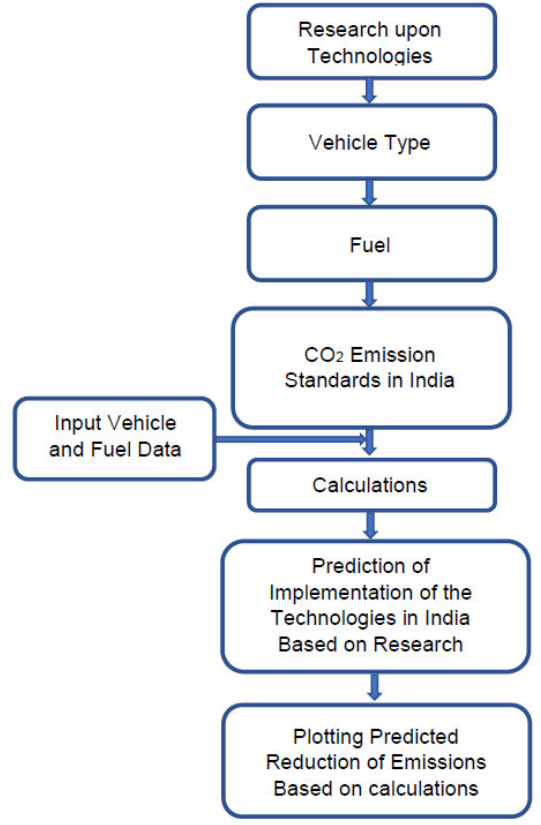
Figure 5. Figure 5. Methodology.